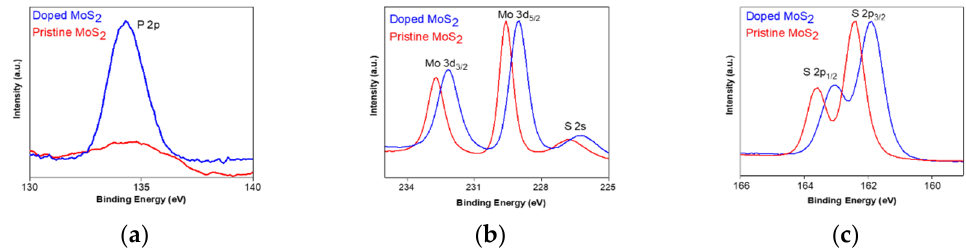
Figure 3. XPS spectra of ( a ) P 2p, ( b ) Mo 3d, and ( c ) S 2p peaks in the pristine and doped MoS 2